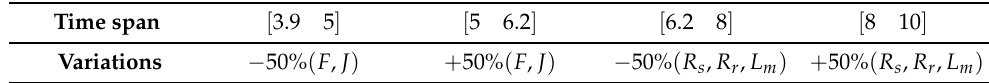
Table 4. Parameters’